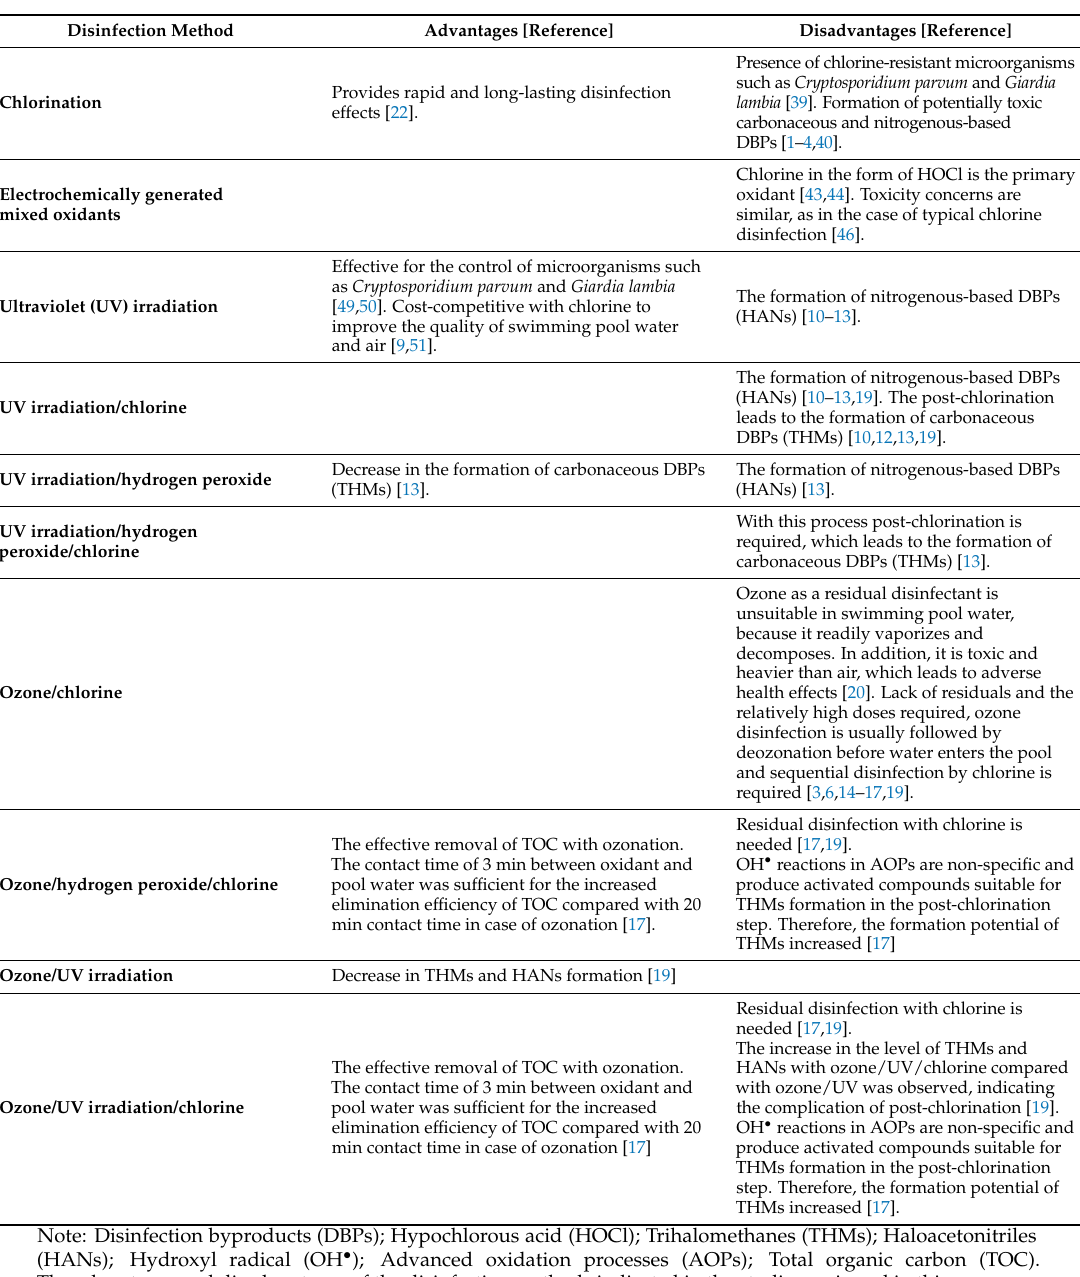
Table 4. Summary of advantages and disadvantages of the disinfection methods for swimming pool